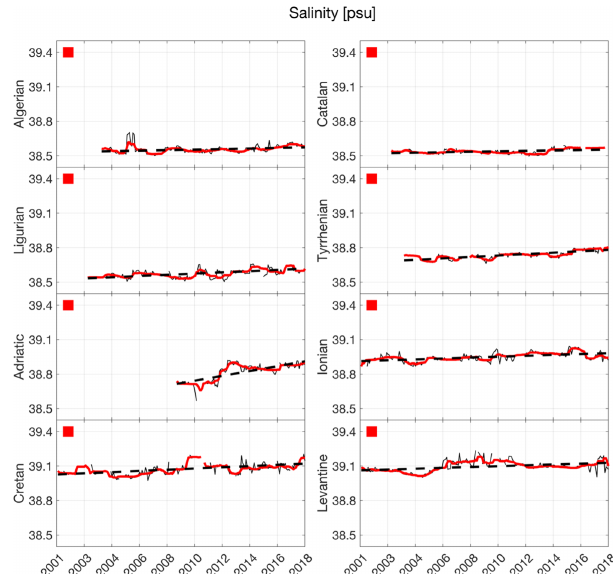
Figure 6. The same as Fig. 3 but for the LIW salinity.